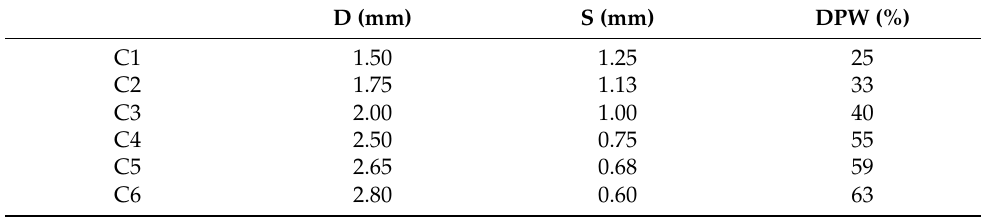
Table 1. Structure identification and dimensions with a fixed unit cell of 4 mm of the specimens tested. D: pore diameter. S: strut diameter. DPW: designed porosity of the specimen. D (mm) S (mm) DPW (%) C1